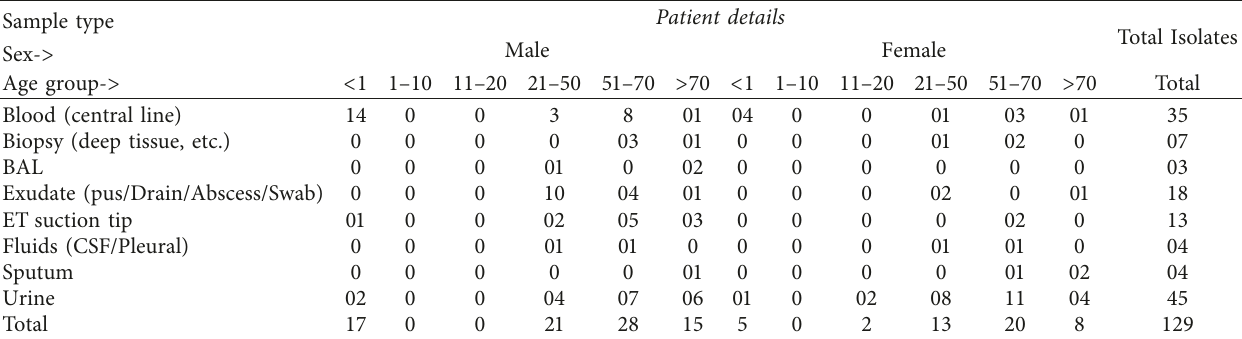
Table 1: Isolation of Klebsiella pneumoniae from various clinical specimen and demographical features of patients included in the study. Sample type